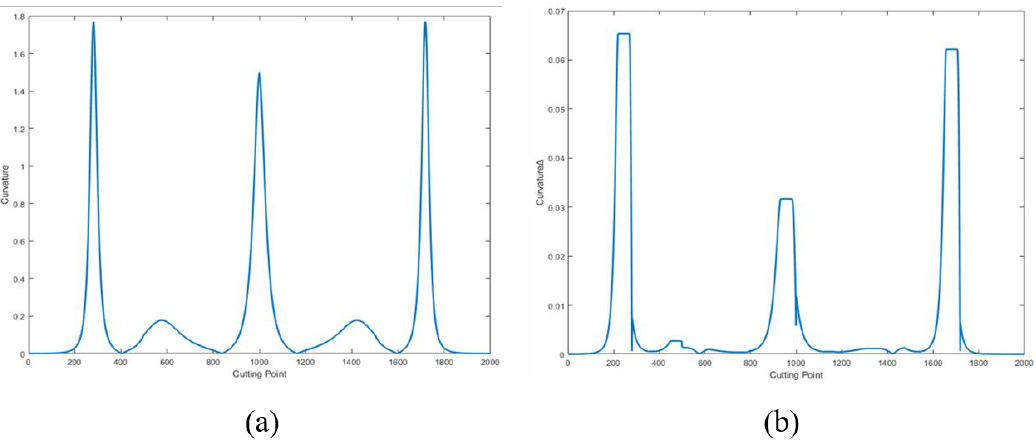
Figure 9. ( a ) Curvature and ( b ) curvature variation of trident shape.